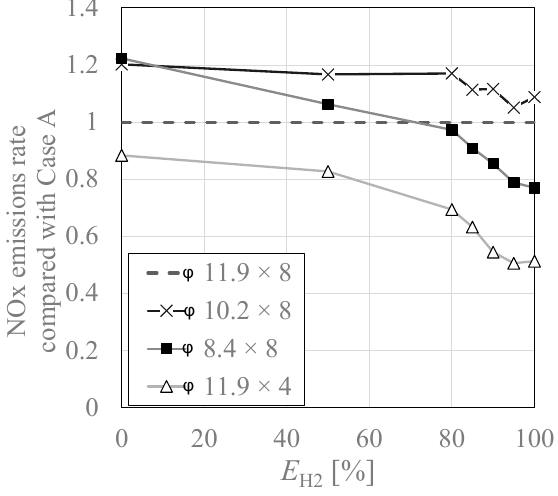
Figure 12. NOx emissions rate compared with φ 11.9 × 8 for different E H2 under each air nozzles case at 1273 K. Input = 174 kW, λ = 1.2, P = +15 Pa.